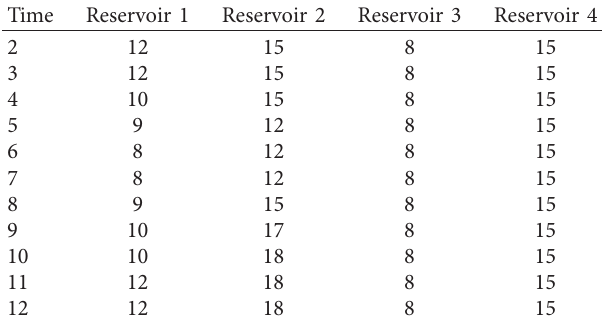
Table 3: Maximum storages for the CFRO system.